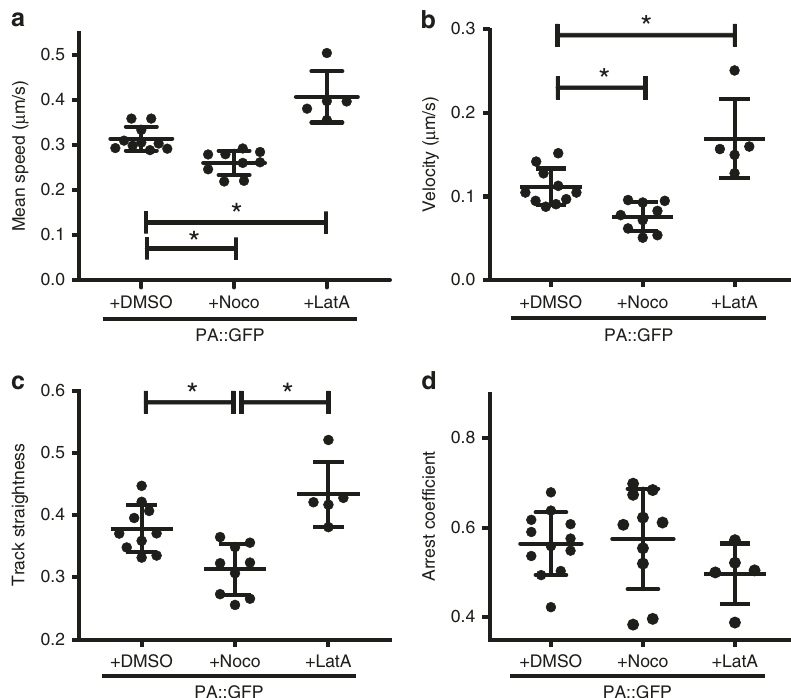
Fig. 4 Effect of cytoskeleton depolymerization on motion dynamics of in fl uenza vRNP in A549 cells. Motion parameters of in fl uenza vRNP segments with a fl uorescently tagged polymerase. A549 cells were infected with H1N1pdm PA::GFP at multiplicity of infection (MOI) = 1 and treated with drugs 4 h post infection (hpi) to allow unhindered viral entry. Imaging was performed 16 hpi at 37 °C on a temperature-controlled stage. Each datapoint represents an individual cell (DMSO: n = 10 cells, nocodazole: n = 9 cells, and latrunculin A: n = 5 cells) using CF 50 for the corresponding motion parameters: a track mean speed, b track mean velocity, c track straightness, and d track arrest coef fi cient. Image processing and analysis were performed as described in Methods. Mean ± SD are shown per group (* implies p < 0.05, comparisons performed using one-way ANOVA with Tukey ’ s multiple tests). Source data are provided as a Source Data fi